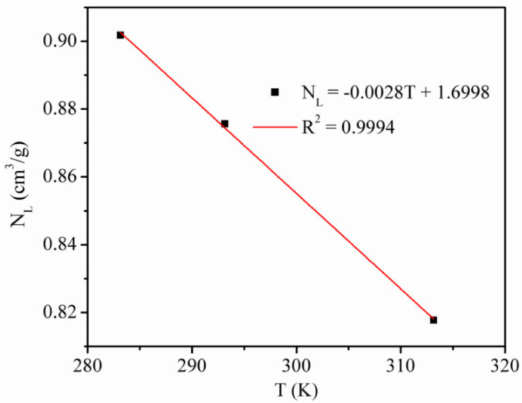
Figure 3. CO 2 maximum absolute amount adsorbed at di ff erent temperatures.